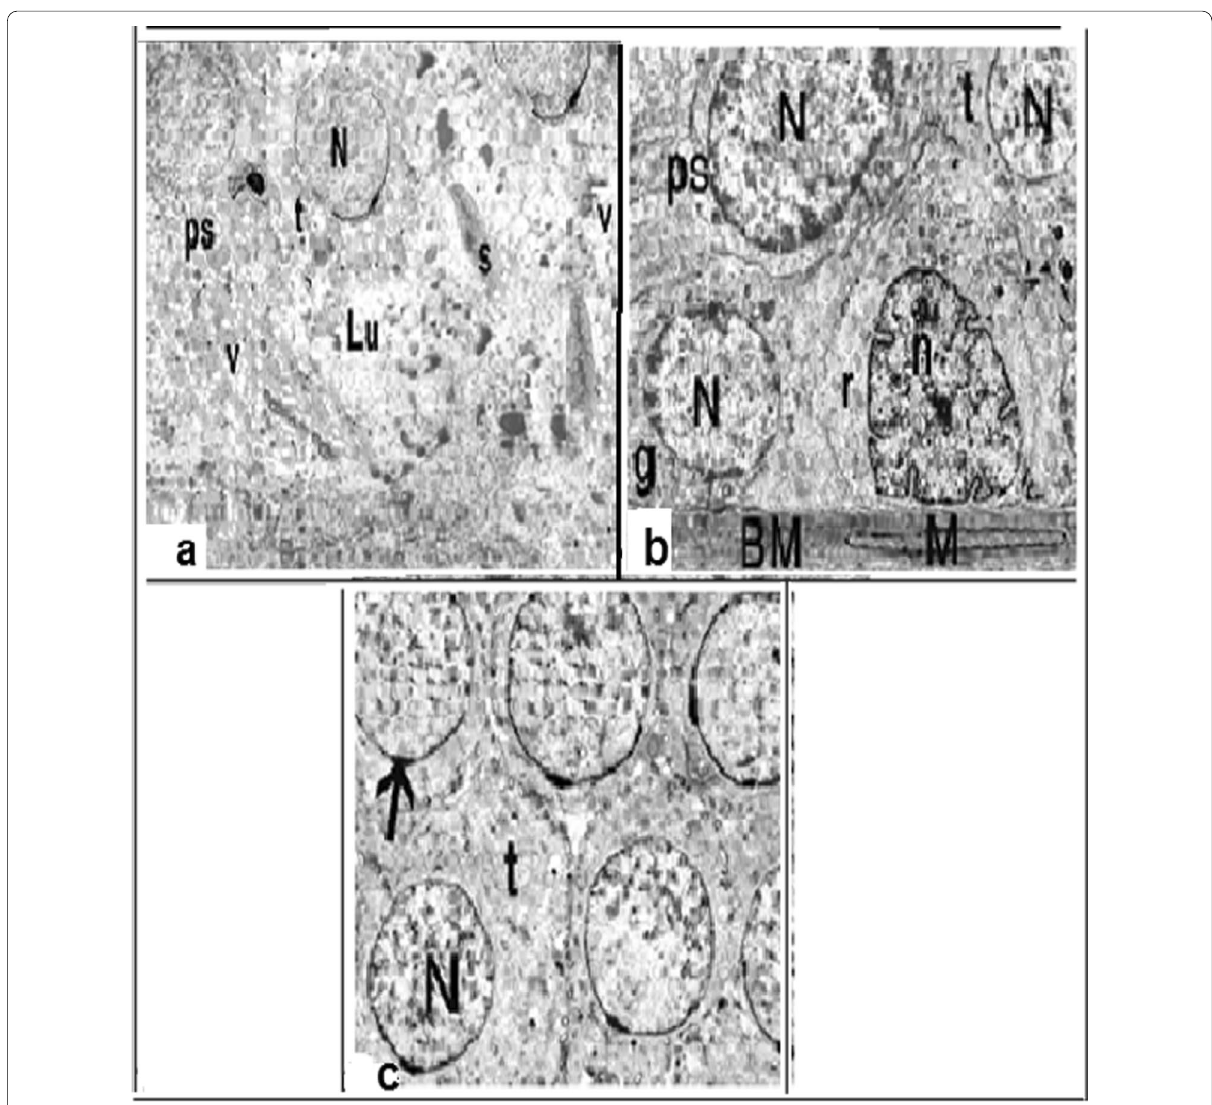
Fig. 4 a Transmission electron micrographs of the third group rat testis showed damaged primary spermatocytes (ps) with cytoplasmic vacuolation, degenerated mitochondria, dilation endoplasmic reticulum, vacuoles of cytoplasm (v) of spermatid with irregular acrosomal cap (t), and irregular nuclear membrane (N) close to the lumen (Lu) (X4000). b Transmission electron micrograph of sections testis of rats of the fourth group: showing: spermatogonia (g) with its small nucleus (N), primary spermatocyte cell (ps) with its large nucleus (N); Sertoli cell (r) with its dentate nucleus (n), rest on regular basement membrane (BM) with flat myoid cell (M) nucleus (N) (X5000). c Transmission electron micrograph of sections testis of rats of the fourth group showing: a group of spermatids (t) with rounded nucleus (N) and acrosomal cap (arrow) and sperm (s)